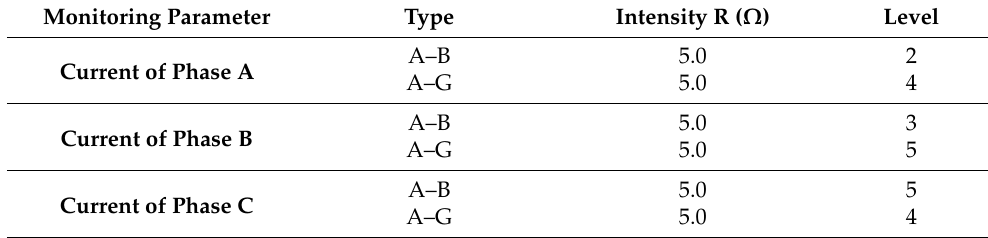
Table 8. Operation with fault at 1.4–1.7 s for ramp load torque.